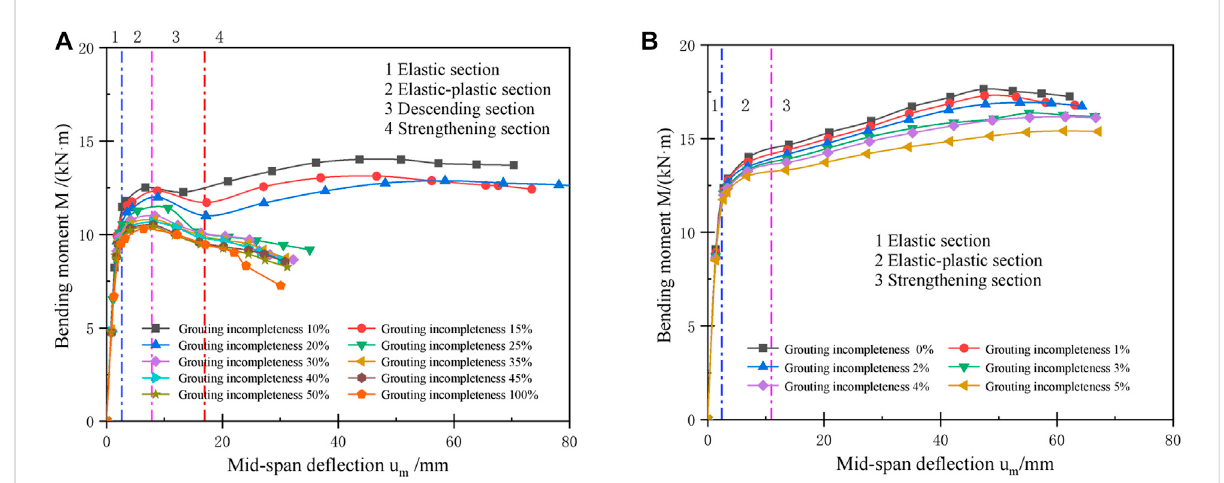
FIGURE 3 Bendingmoment — mid-spande fl ectioncurveofgrouting piperoof (A) Groutingincompleteness 10% – 100%;and (B) Grouting incompleteness 0% –